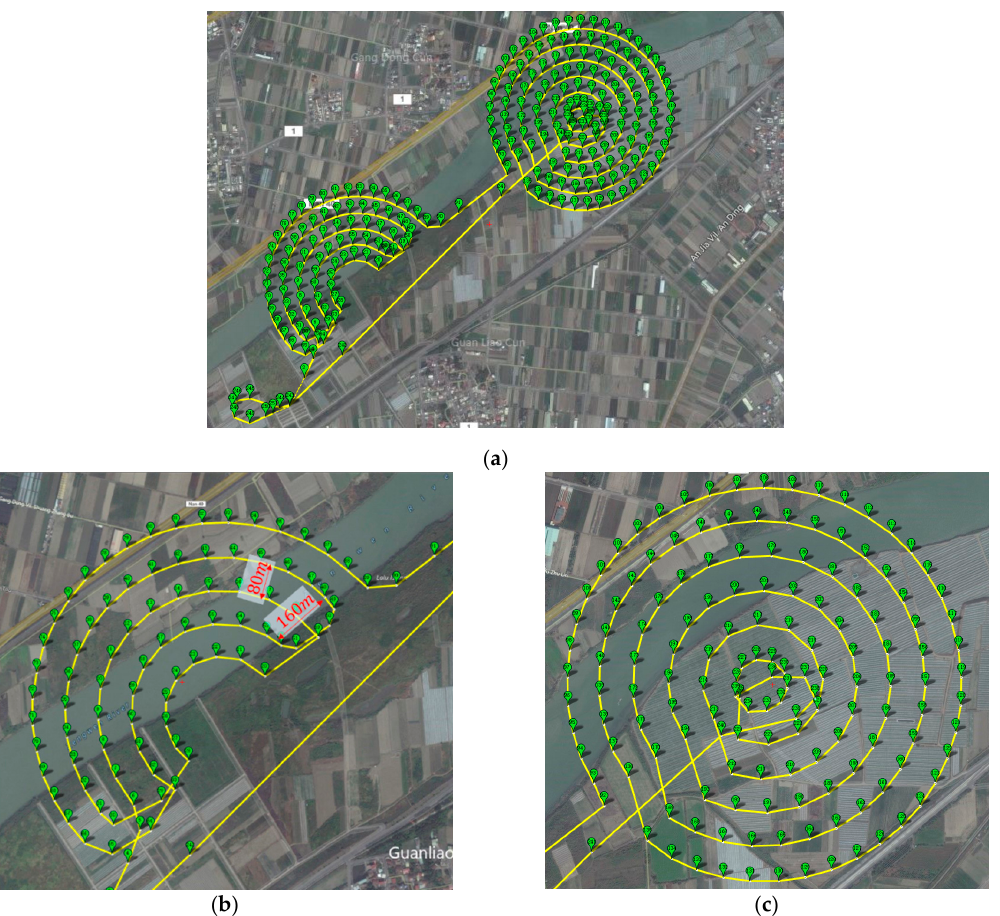
Figure 25. ( a ) Overall flight plan for the search mission, ( b ) flight plan for search area B (the turning diameter reaches 160 m to ensure the flight performance while the distance between the two flight paths remains 80 m, guaranteeing full coverage and overlap) and ( c ) flight plan for search area A.